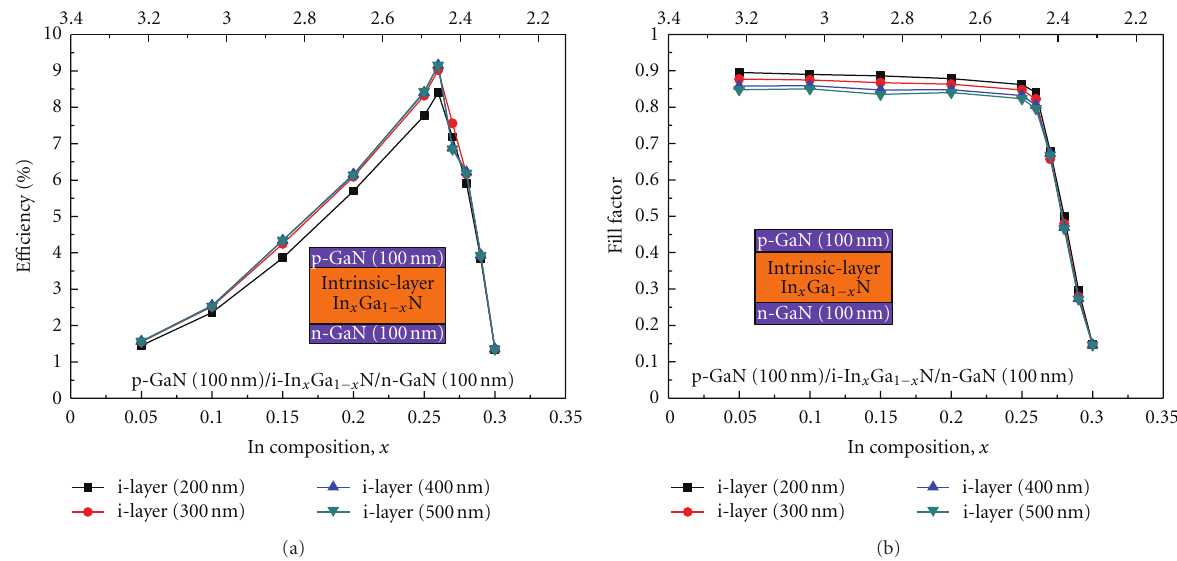
Figure 3: The e ffi ciency (a) and the fill factor (b) of a p-GaN (100nm)/i-In x Ga 1 − x N (200 ∼ 500 nm)/n-GaN (100nm) solar cells with an In composition of x = 0 . 05–0 . 3.